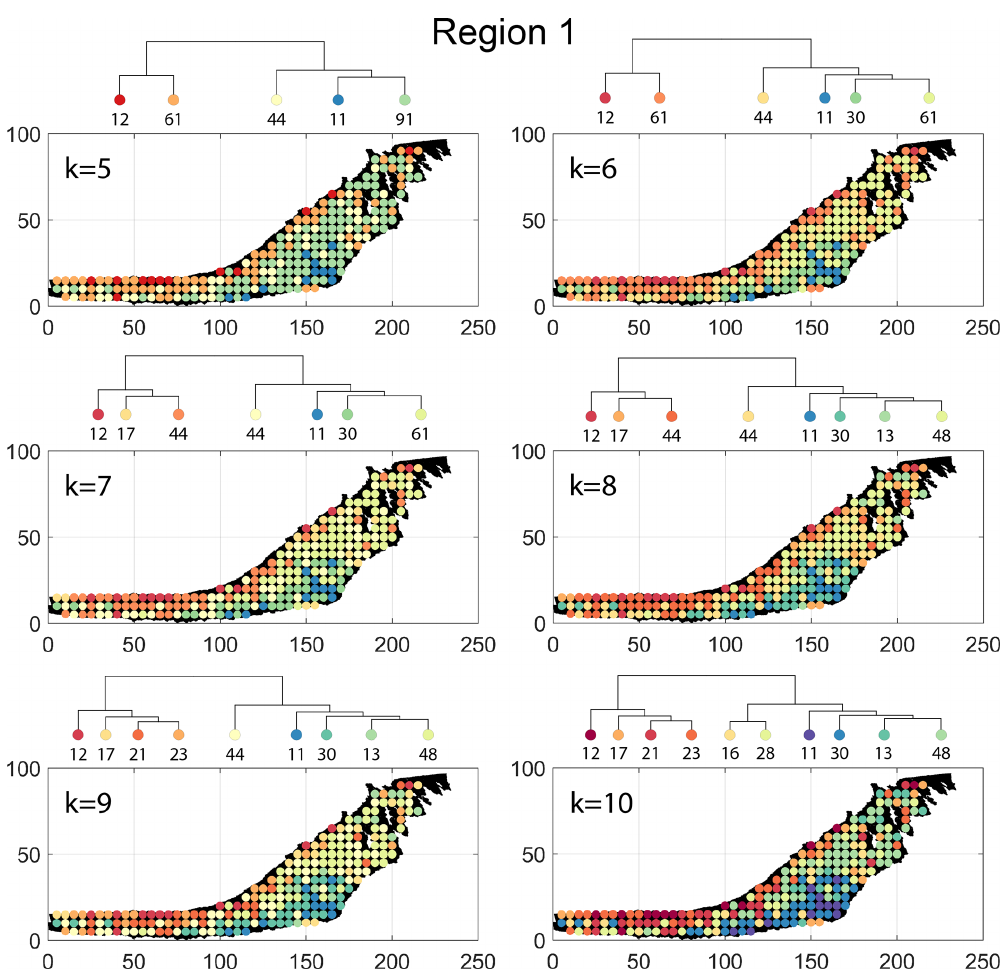
Figure B3. Variation in cluster boundaries for “ k ” clusters in Region 1 using NetLSD.